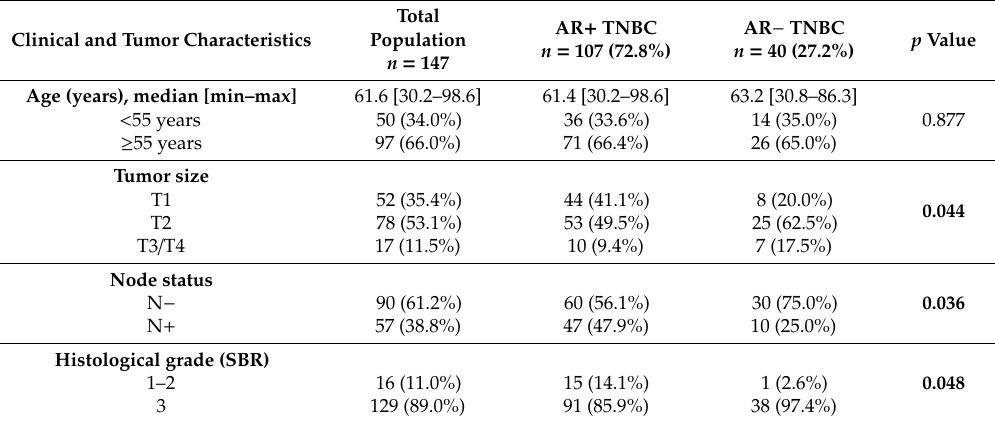
Table 1. Clinical and tumor characteristics of the whole population and according to the triple-negative breast cancer (TNBC) androgen receptor (AR)